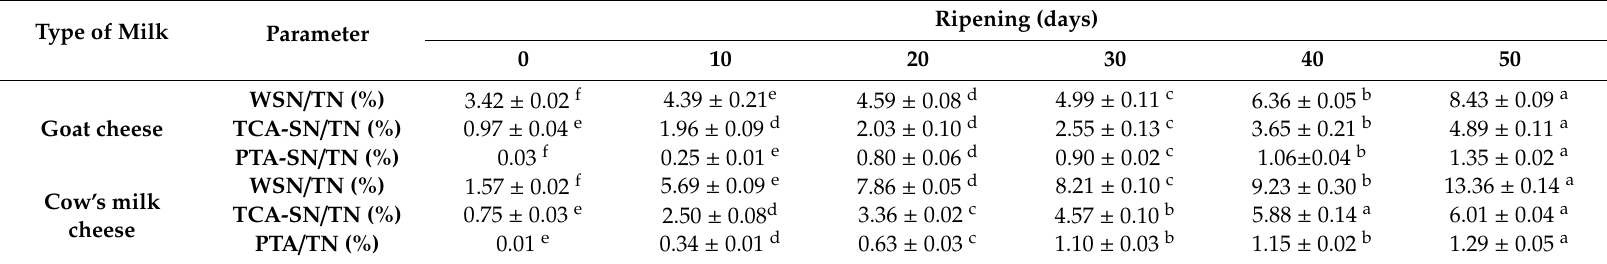
Table 2. The change of ripening parameters of experimental goat and cow’s milk